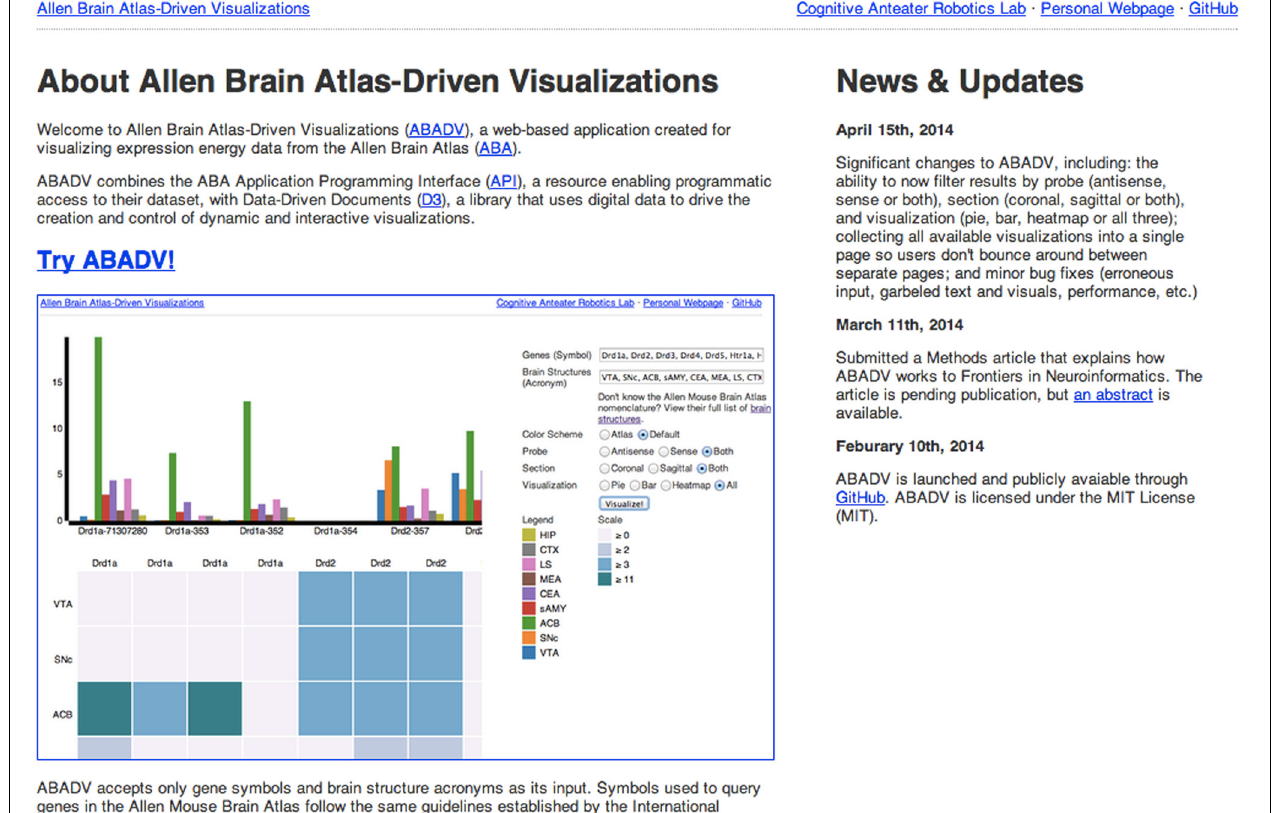
FIGURE 2 | Screenshot of ABADV Main Page. A screen capture of the main page for ABADV.